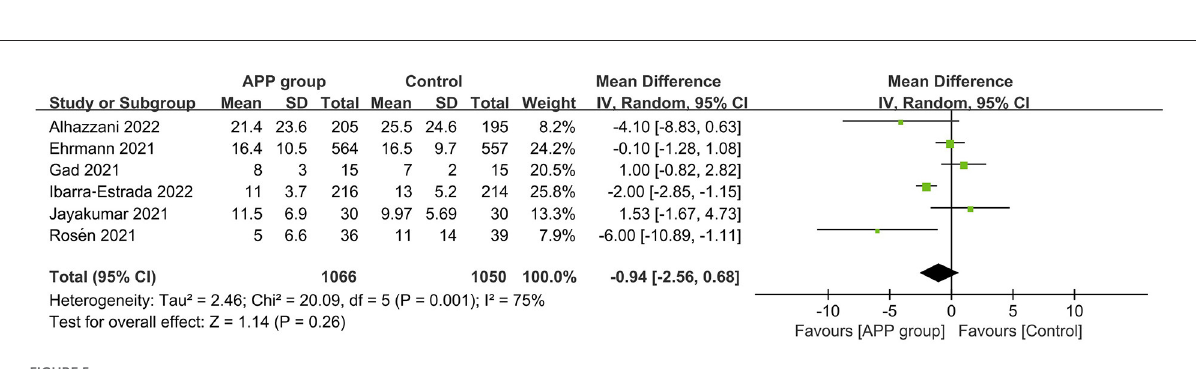
FIGURE5 Forest plots of the effects of awake prone position on the length of stay in the intensive care